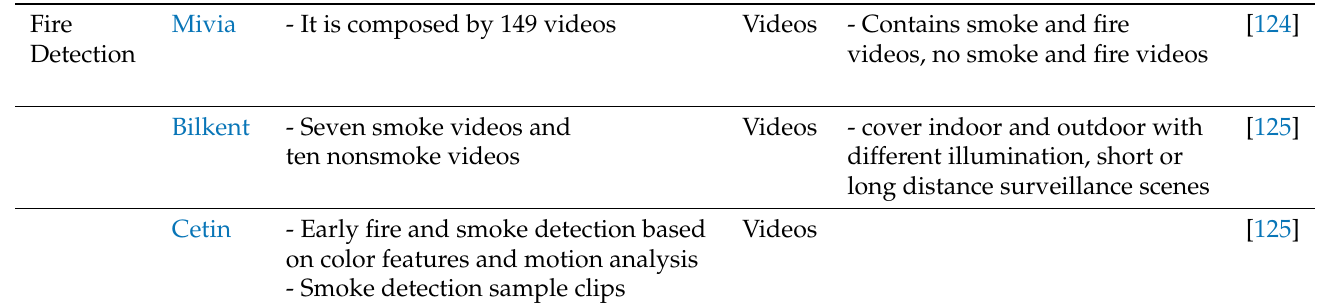
Table 10. Frequently used